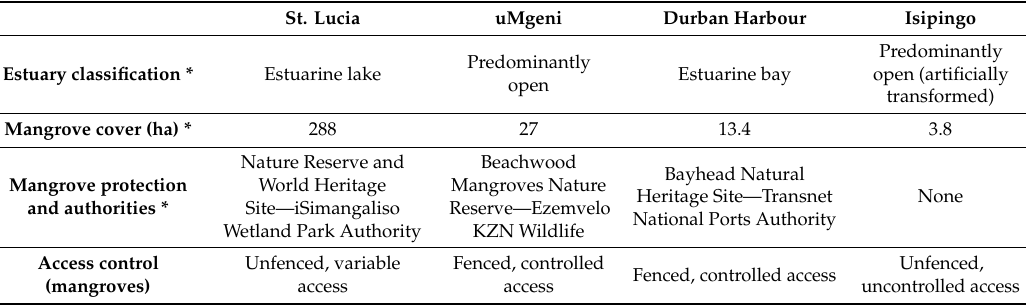
Table 1. Classification, mangrove cover and forest access control of each